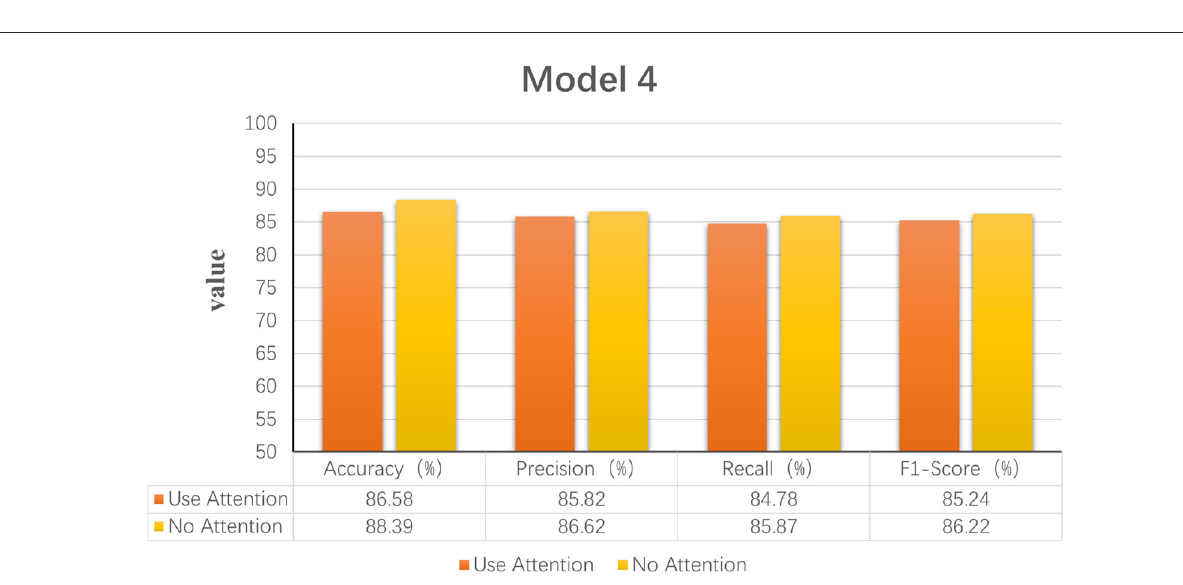
FIGURE6 Statistical graphs of the evaluation results of the model with the addition of attention mechanism vs.